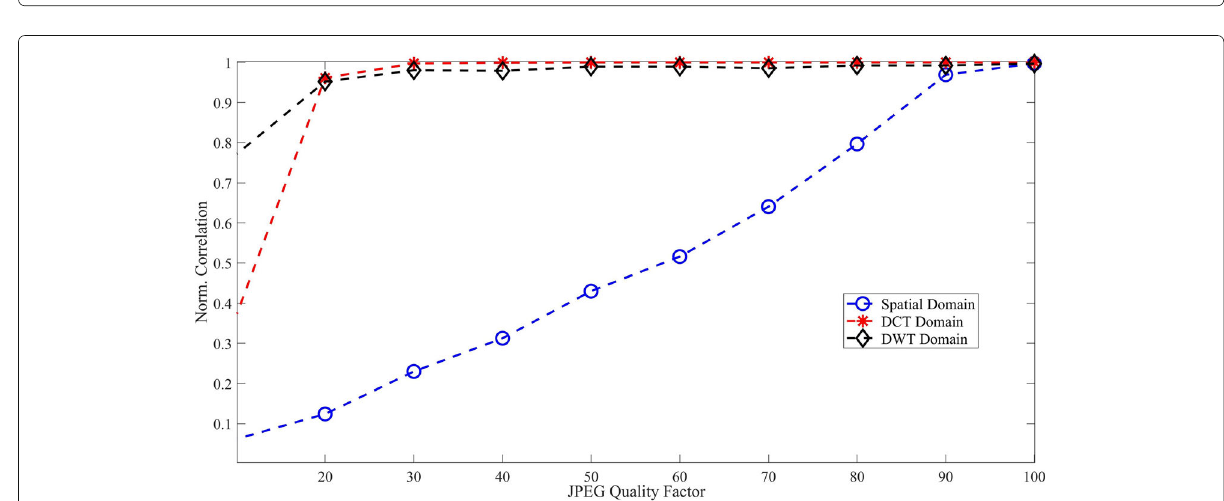
Fig. 10 Correlation value versus JPEG quality factor in three investigated domains (averaged over 50